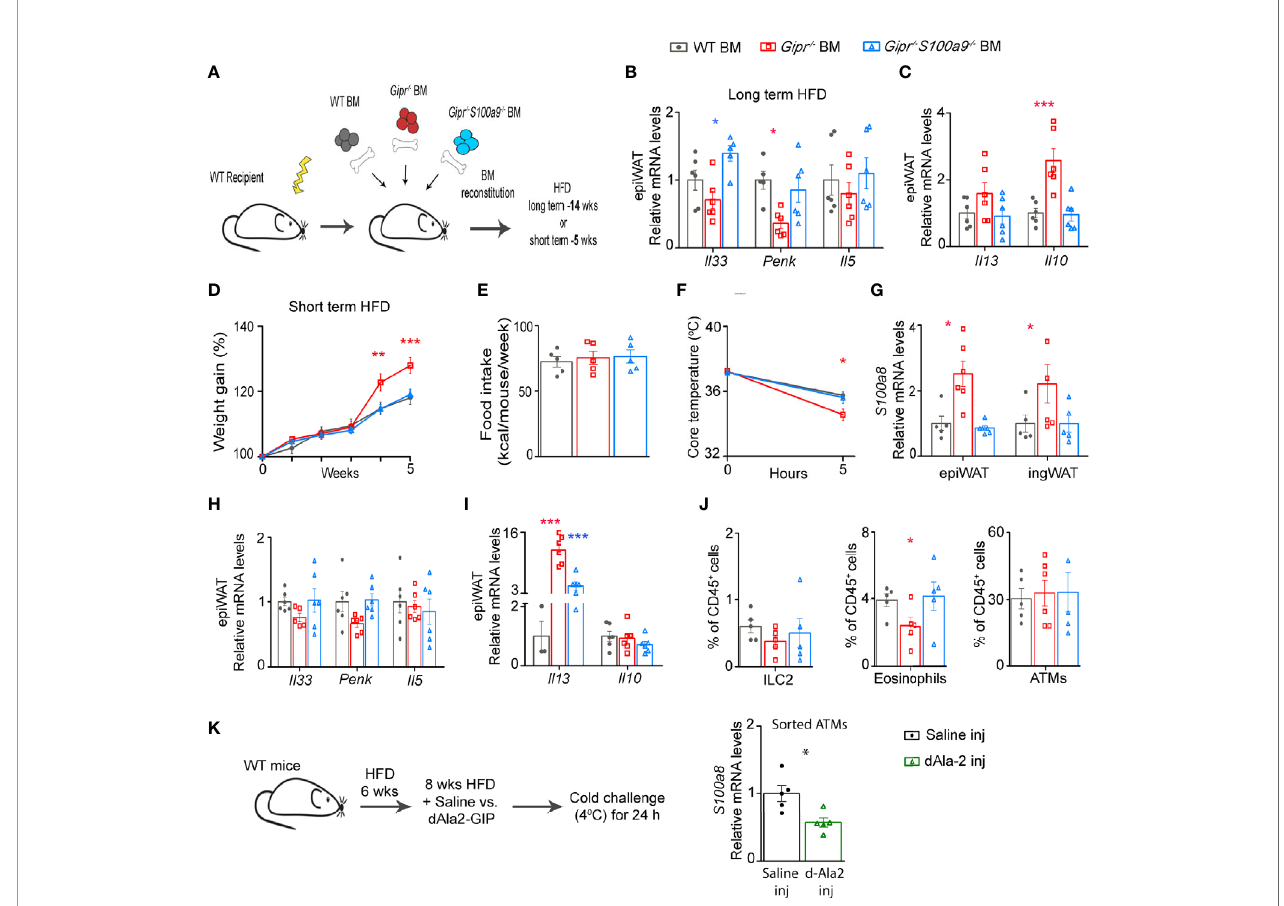
FIGURE 3 | Unrestrained production of S100A8/A9 by Gipr -/- immune cells impedes WAT type 2 immune circuits. (A) Scheme illustrating experimental design. Lethally irradiated WT mice were reconstituted with WT BM (gray circles), Gipr -/- BM (red squares) and Gipr -/- /S100a9 -/- BM (blue triangles) for 6 weeks and then fed with a HFD regime as indicated for (B , C) long-term (14 weeks) or (D – J) short-term (5 weeks). (B, C) qRT-PCR assessment of the expression of the indicated mediators normalized to Rplp0 in epiWAT after 14 weeks of HFD (n=6). (D, E) Weekly measurements of body weight and food consumption (kcal/mouse/week) during 5 weeks HFD feeding (n ≥ 6). (F) Body core temperature response (°C) to acute cold challenge after 5 h. (G) Expression of S100a8 gene in epiWAT and ingWAT as determined by qRT-PCR. (H, I) Gene expression of indicated mediators in epiWAT after 5 weeks of a HFD as analyzed by qRT – PCR and normalized to Rplp0. (J) Graphs showing fl ow cytometry assessment of ILC2, eosinophils and ATMs fractions out of total CD45 + cell population (de fi ned as shown in Figure 2A ). (K) Scheme illustrating experimental design. WT mice were subjected to HFD feeding for 14 weeks and received daily i.p. injections of dAla2-GIP analogue (60 nmol/ kg body weight) or vehicle (saline) during the last eight weeks (n= 8). Left panel, qRT-PCR analysis of S100a8 expression in ATMs sorted from epiWAT of these mice. Data are from single experiment. Data are presented as mean ± SEM. Statistical analyses were conducted using one-way ANOVA followed by post-hoc Tukey test (B, C) or by unpaired two-tailed t -test (K) with signi fi cance: *p ≤ 0.05, **p ≤ 0.01 and ***p ≤ 0.001. Red or blue stars represent signi fi cance of Gipr -/- BM or Gipr -/- /S100a9 -/- BM groups vs. WT BM,